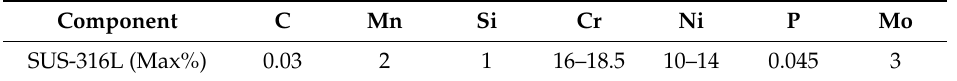
Table 1. Chemical elements 316L SUS wire.